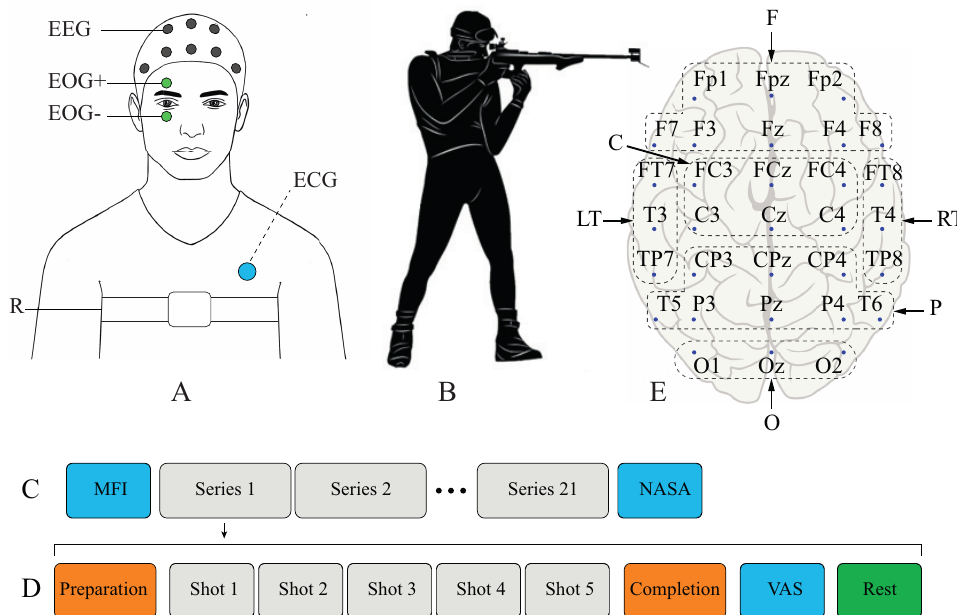
Figure 1. ( A ) Experimental setup with sensors: EEG (grey circles), EOG (green circles), ECG (blue circle), respiration (white stripe); ( B ) Shooting stance; ( C ) General design of the experimental session; ( D ) Design of individual series; ( E ) Scheme of EEG electrodes placement “10-10”. Chosen areas of EEG signals averaging are shown with dotted frames: frontal (F), central (C), parietal (P), occipital (O), left temporal (LT), and right temporal